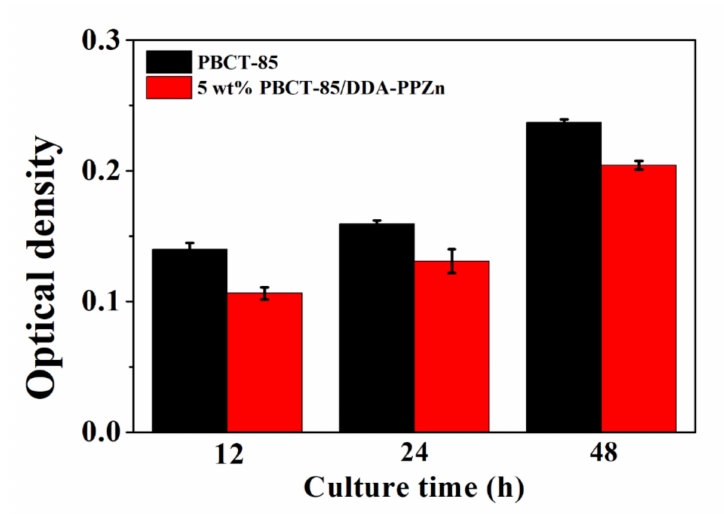
Figure 10. Biocompatibility of PBCT-85 / DDA-PPZn seeded with L929 cells at various time